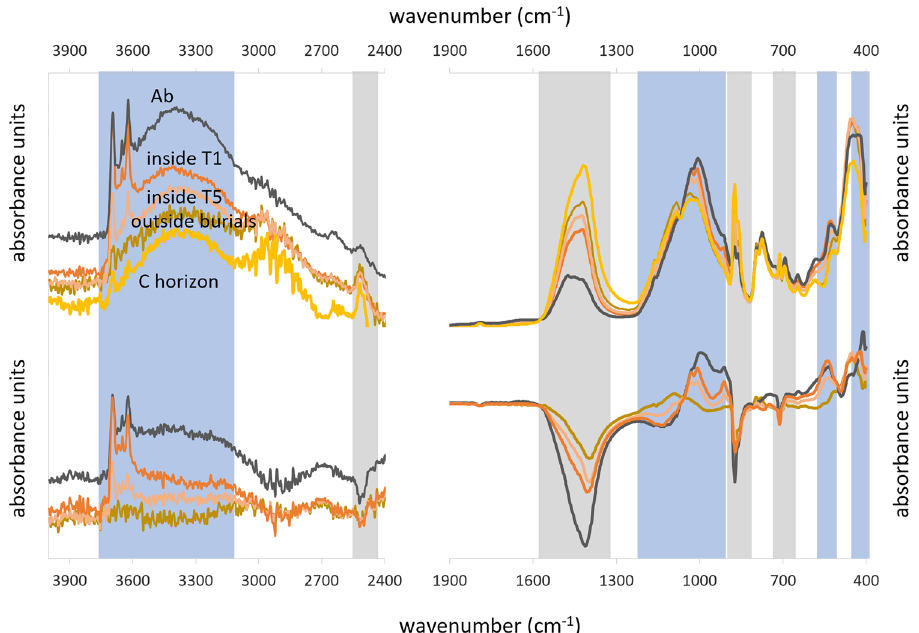
Figure 3. ( A ) Average spectra of the paleosol (black, Ab; yellow, C horizon), inside T1 (orange), inside T5 (pink), samples outside burials (dark brown). ( B ) Difference spectra compared to the dune sands, in blue the sections where the difference is positive and in grey where it is